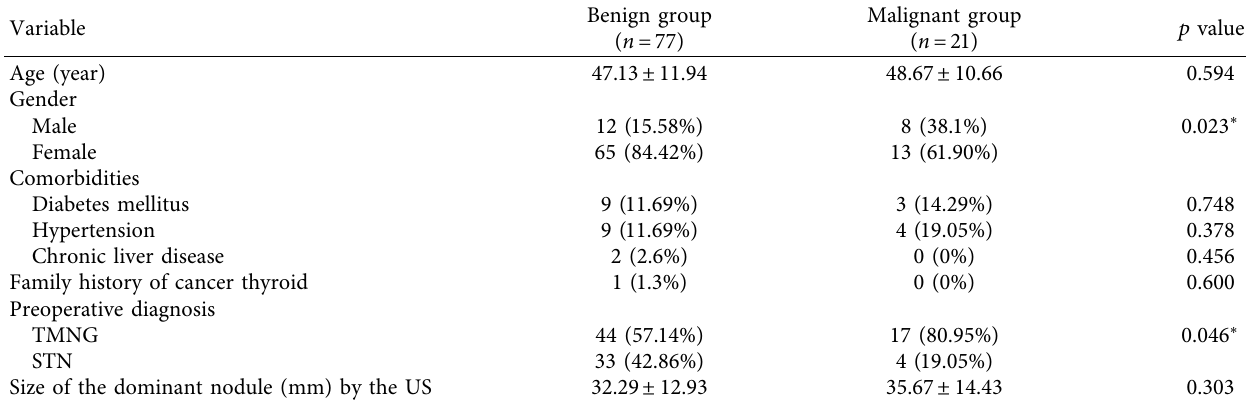
Table 1: Preoperative data.